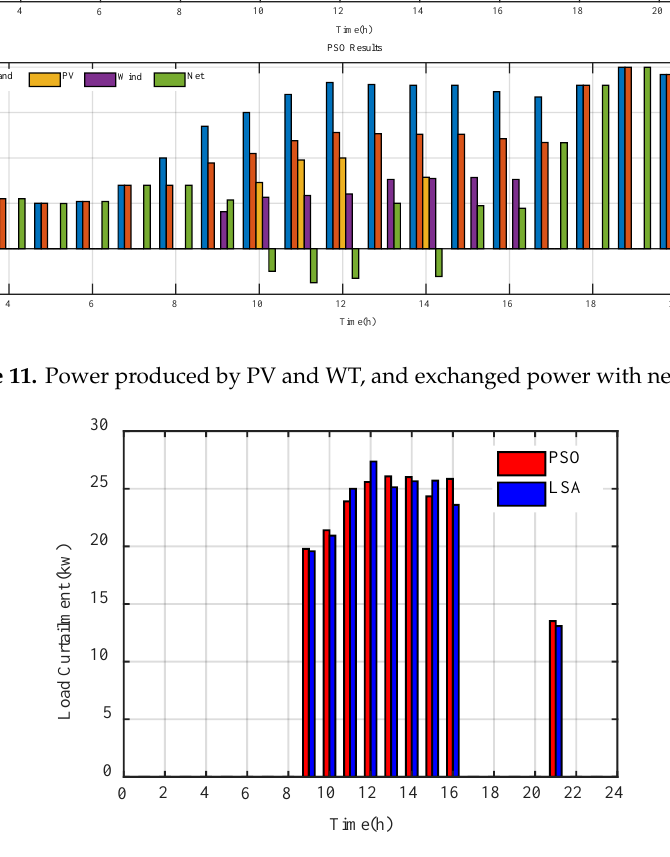
Figure 11. Power produced by PV and WT, and exchanged power with network.